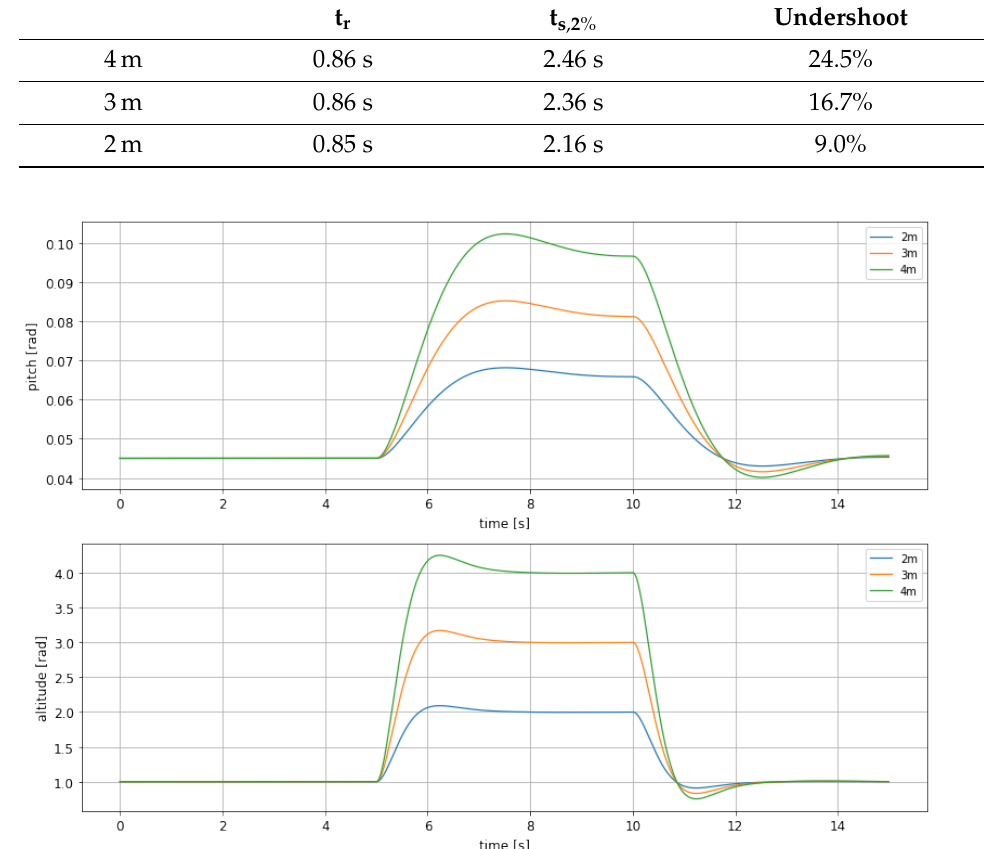
Figure 12. Comparison between the altitude and pitch dynamic for the updating LQR with different rise